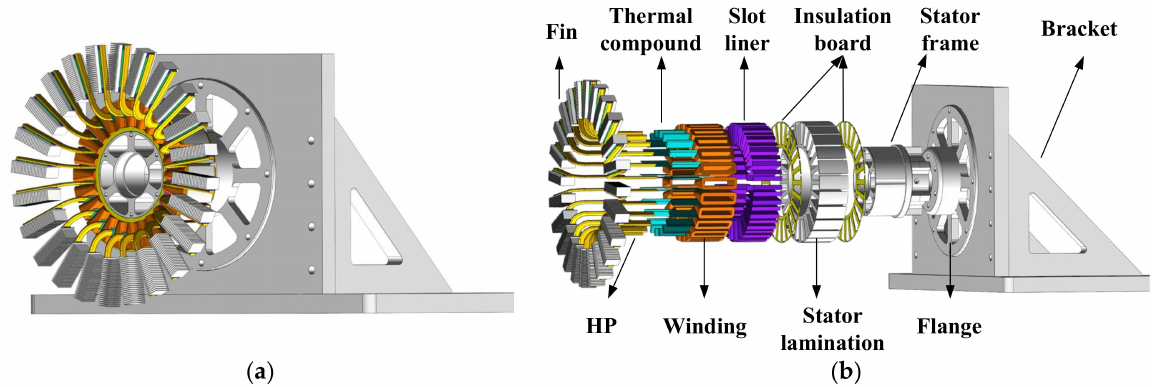
Figure 3. Schematic of specimen construction based on a stator-winding assembly. ( a ) Specimen outline. ( b ) Detailed view.